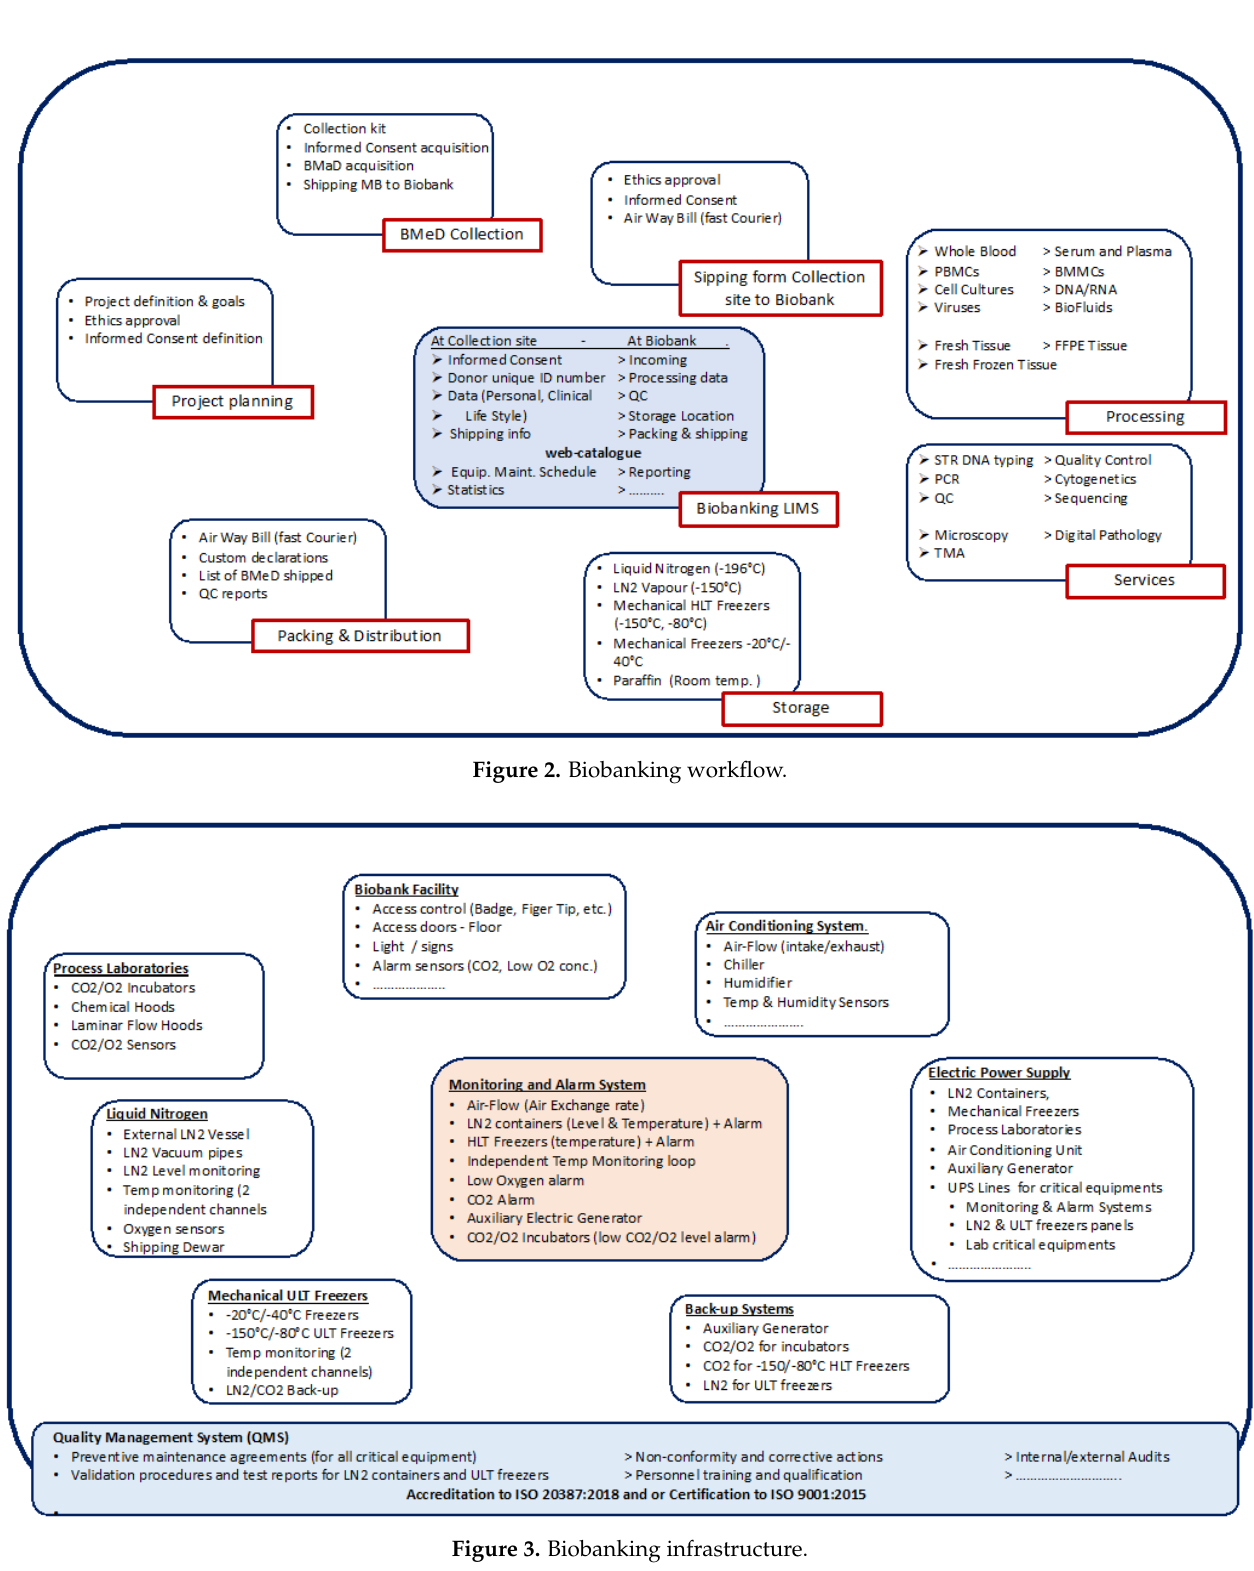
Figure 3. Biobanking infrastructure.